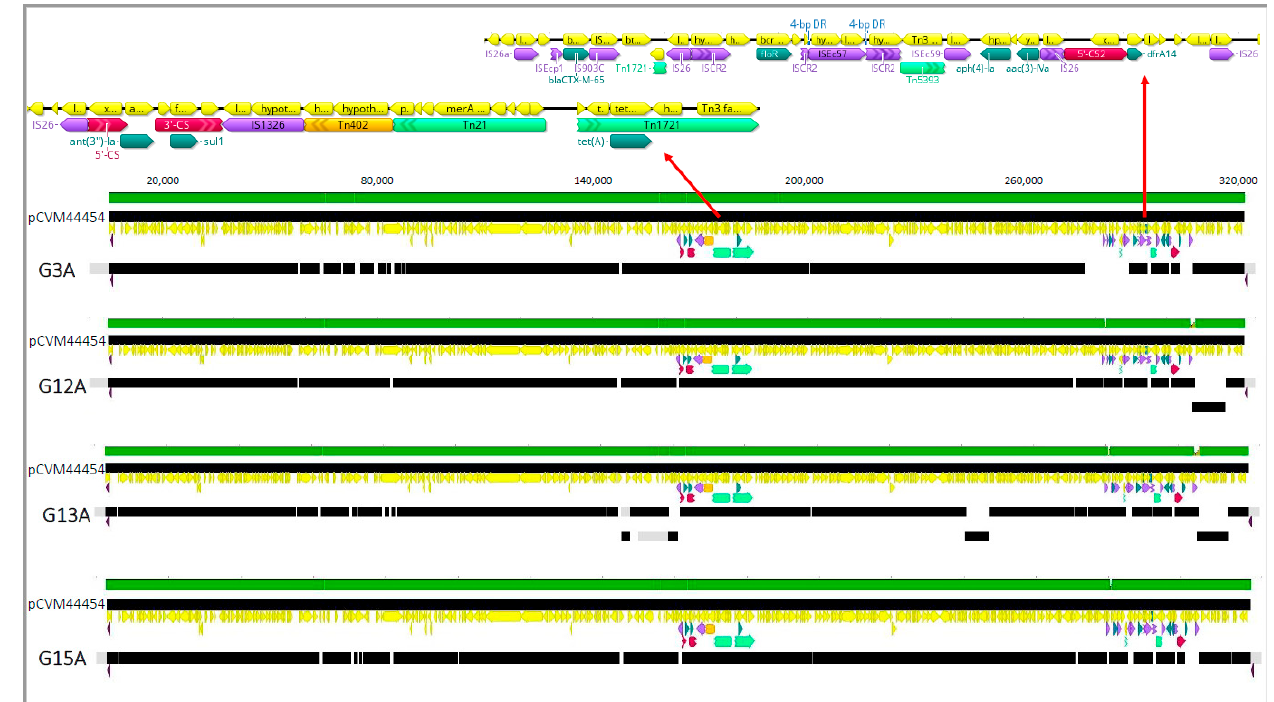
Figure 1. Plasmid map for isolates of Salmonella Infantis obtained from Galapagos Island containing antimicrobial. Diagram created in Geneious Prime. Assembled contigs from each sequenced isolate were mapped to the closed reference plasmid pCVM44454 (GenBank Accession CP016413), annotated using prokka (V1.14.0) and Galileo AMR (1, https://galileoamr.arcbio.com/mara/ accessed on 5 March 2021). Green bars show identity between reference plasmid (above) and mapped contigs (black bars) from each sequenced isolate. Two resistance regions are shown as larger images above. Resistance genes and cassettes are labeled and shown as teal arrows, conserved segments of integrons (5 ′ -CS and 3 ′ -CS) as pink arrows, insertion sequences as purple arrows, transposons as light green boxes, and direct repeats by blue labels. Position numbering of the resistance regions in the reference plasmid is shown above.